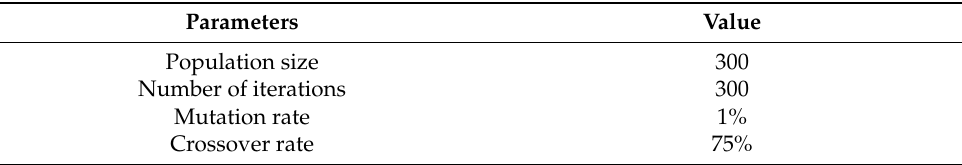
Table 1. Genetic Algorithm Parameters.